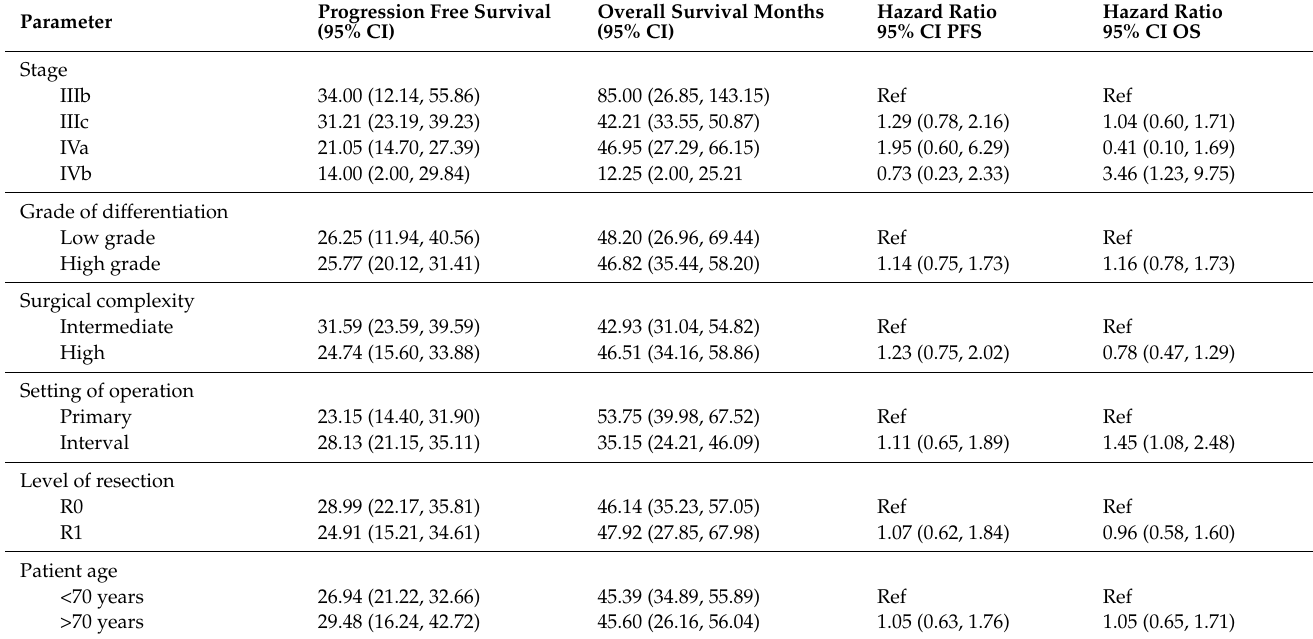
Table 2. Survival outcomes among selected subgroups of patients. Progression-free survival and overall survival in months. PFS = progression-free survival, OS = overall